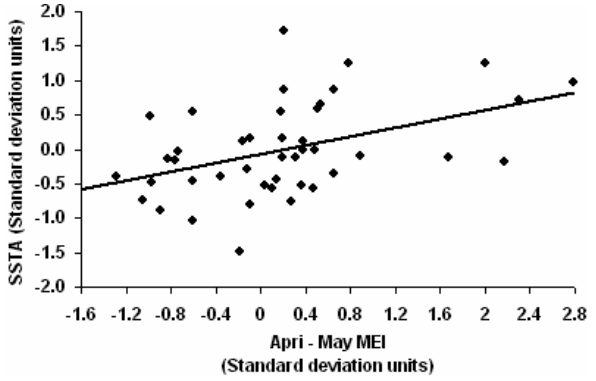
Fig. 3. Scatter plot of June to September averaged SSTA versus the Figure 3. Scatter plot of June to September averaged SSTA versus the April-May MEI April–May MEI for the Trivendrum, from 1960 to 2003. The equa- for the Trivendrum, from 1960 to 2003. The equation of the linear regression fitted to tion of the linear regression fitted to the data is SSTA=0.32 × MEI the data is SSTA = 0.32xMEI (with r² = 0.45 and p < 0.01). (with r 2 =0.45 and p<